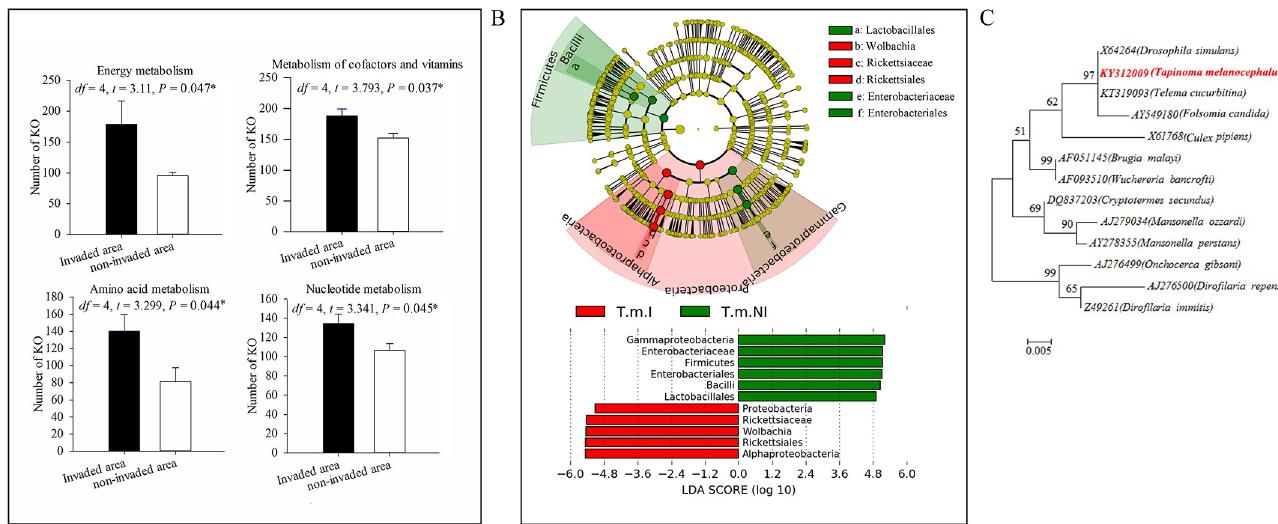
Fig 4. Functional analysis of bacterial symbionts from T . melanocephalum workers from S . invicta invaded and non-invaded areas. (A) According to PICRUSt analysis, the most enriched metabolic pathways for symbionts in T . melanocephalum workers represented as mean number of KO (KEGG orthology) ± SE for energy metabolism, metabolism of cofactors and vitamins, amino acid metabolism and nucleotide metabolism, Independent sample t test, n = 3 biological replicates, P values in the chart were adjusted by a False Discovery Rate (FDR) correction to account for multiple testing [88]). (B) Bacterial groups that differ between T . melanocephalum workers from S . invicta invaded and non-invaded areas based on LEfSe analysis. T.m.I: T . melanocephalum in S . invicta invaded areas; T.m.NI: T . melanocephalum in S . invicta non-invaded areas. (C) V3+V4 areas of the 16S rRNA gene phylogeny of Wolbachia from workers of T . melanocephalum (441 aligned nucleotide sites). Host insect names are in brackets. Bootstrap values (500 replicates) greater than 50% are indicated at the nodes. Sequences of Wolbachia collected from T . melanocephalum workers are in red font. Asterisks indicate significant differences ( � P < 0.05).